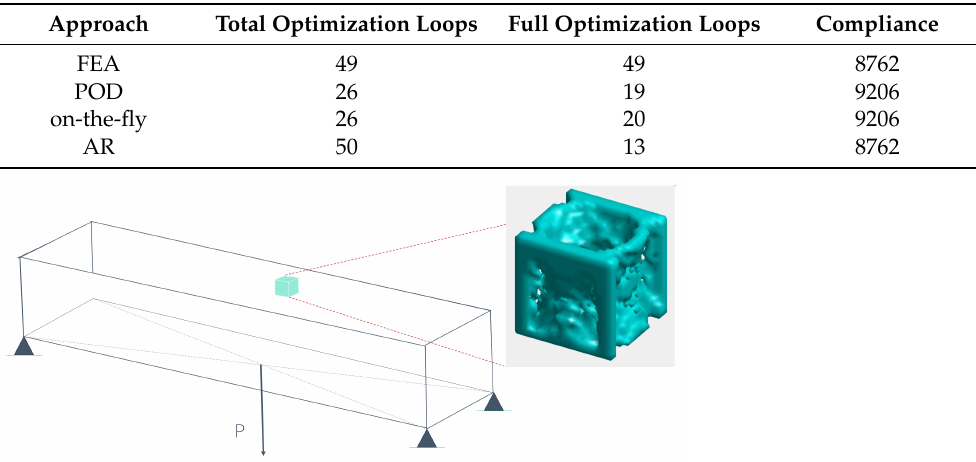
Table 3. 3D MMB Beam: Results of each MOR approach as well as the classic implementation.